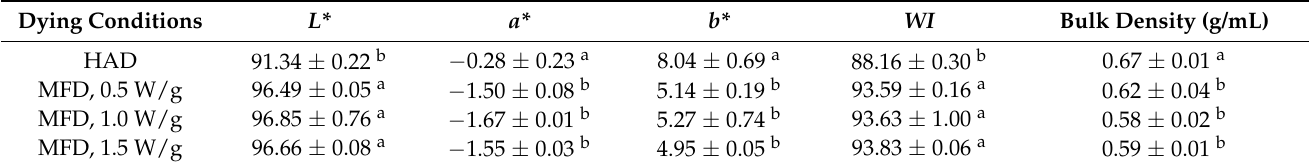
Table 1. Color and bulk density of dried yam flour processed by HAD and MFD.